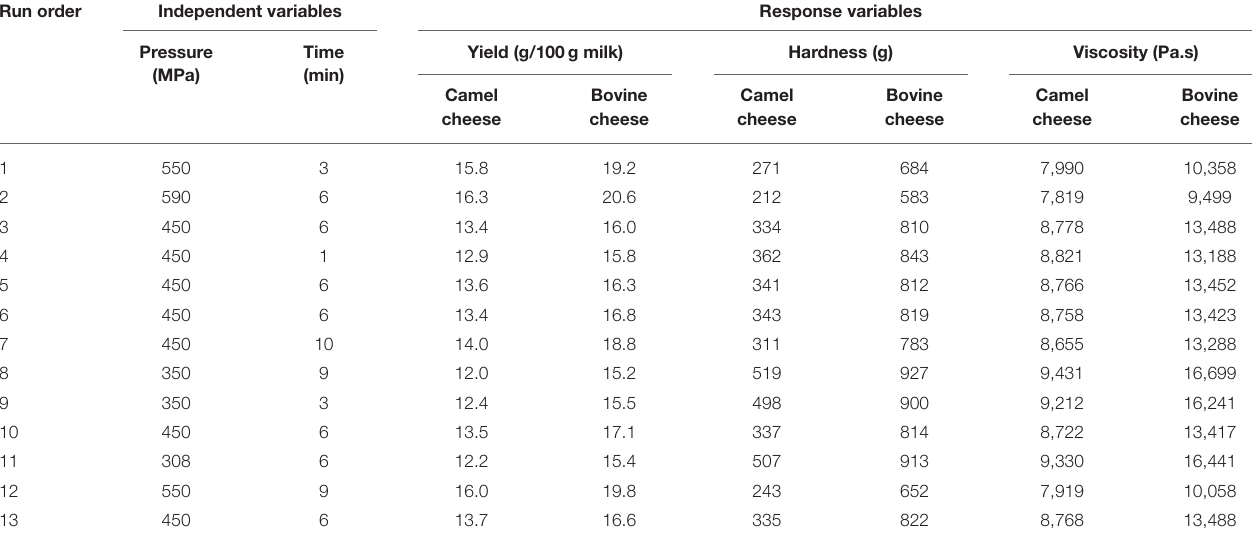
TABLE 1 | Experimental design of the independent variables (pressure, time, and 4 ◦ C) and results of associated response variables (cheese yield hardness and viscosity). Run order